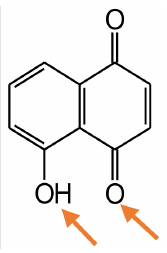
Figure 3. Chemical structure of 5-hydroxyl-1,4-naphthoquinone (juglone) with two active sites for metal-based complex formation.